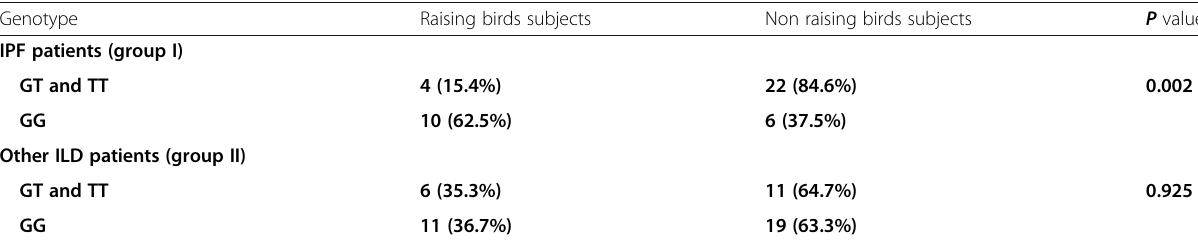
Table 5 The genotypes of MUC5B promoter polymorphism as regards the history of raising birds among the IPF patients and the other ILD patients groups